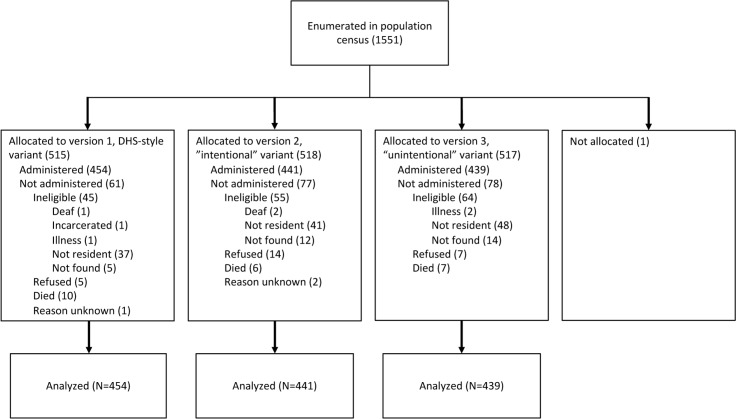
Consolidated Standards of Reporting Trials (CONSORT) flow diagram depicting enrollment, allocation to survey condition, follow-up, and data analysis.DHS, Demographic and Health Surveys.